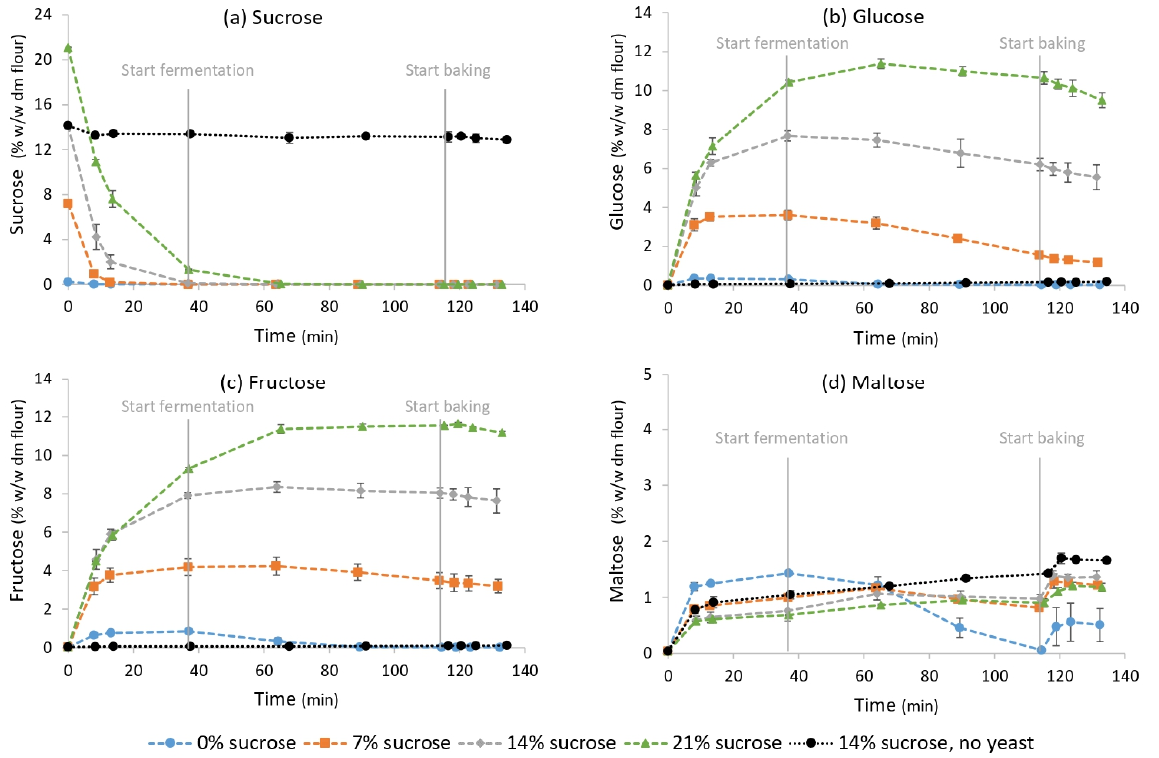
Figure 2. Evolution of ( a ) sucrose, ( b ) glucose, ( c ) fructose and ( d ) maltose concentrations in pastry samples with 8% yeast and 0, 7, 14 and 21% sucrose and samples with 0% yeast and 14% sucrose as a function of time (min) during pastry production. Concentrations are expressed on flour dry matter base (% w / w dm flour). The start of mixing is defined as t = 0. The end of the mixing phase, and the start of the fermentation and baking phases are displayed. Vertical bars represent standard deviations of duplicate measurements.